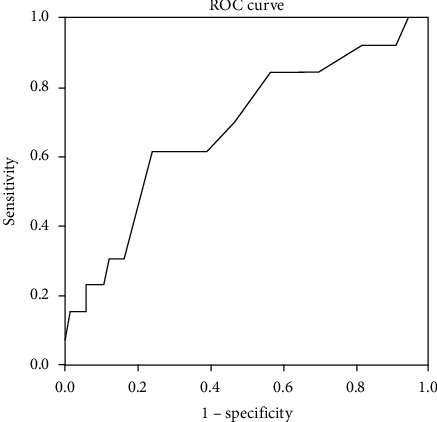
FFA in CSF and neurological causes of mortality. Diagonal segments are produced by ties.